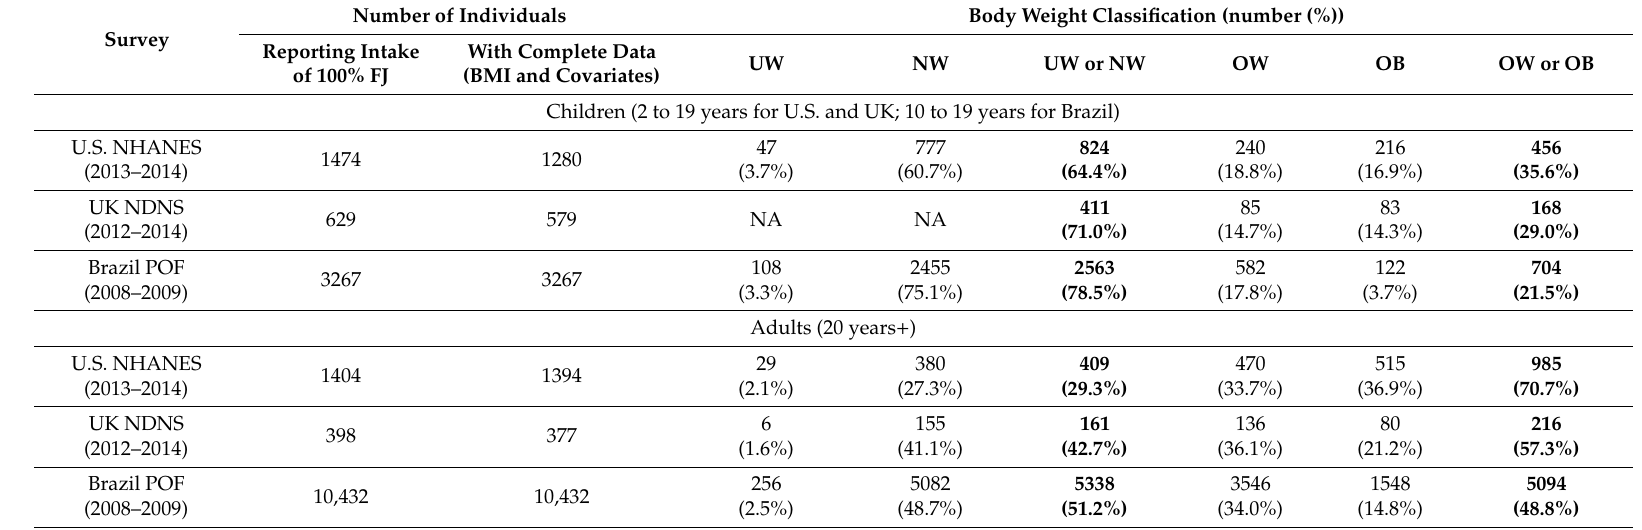
Table 2. BMI classifications among individuals reporting 100% FJ